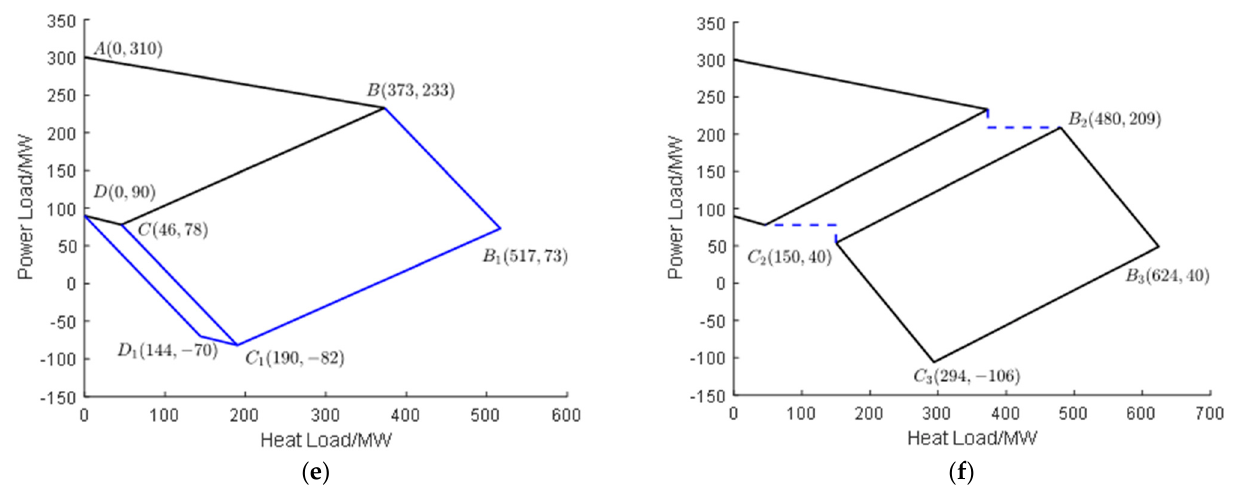
Figure 2. Electrical and thermal operating characteristics of energy supply equipment in the CHP plant. ( a )HBP. ( b ) EH. ( c ) LPCC. ( d ) HBP + EB. ( e ) EH + EB. ( f ) LPCC + EB.